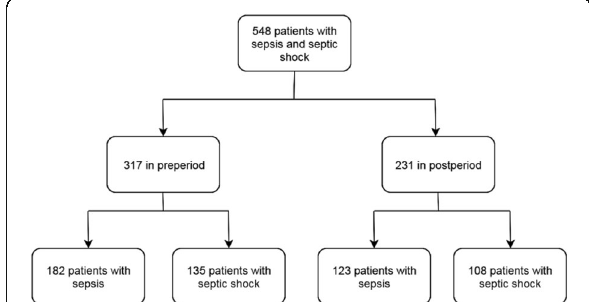
Fig. 1 (abstract P13). Flow chart of study